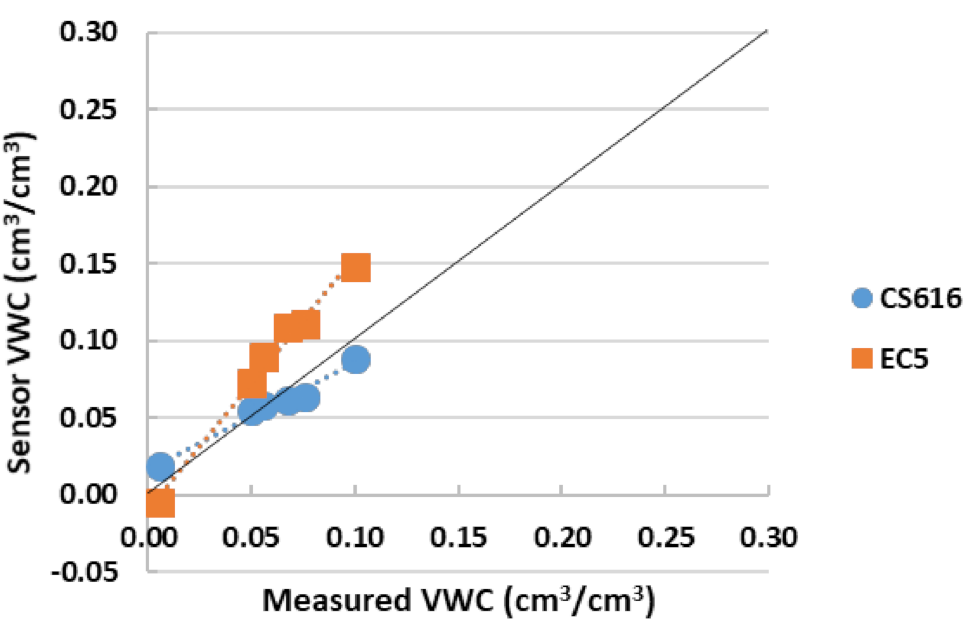
Figure 2. Comparison of CS616 and EC5 with soil sampling method for sand.